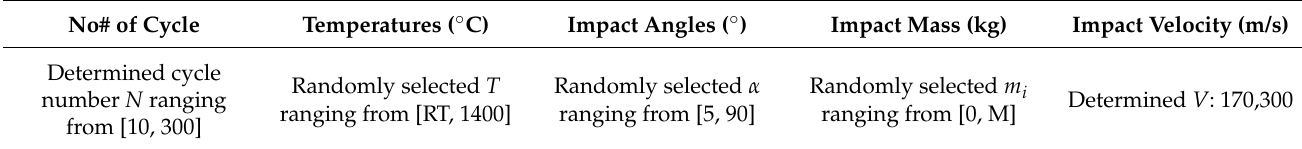
Table 6. Parameters used to calculate erosion rates under different impact velocities.